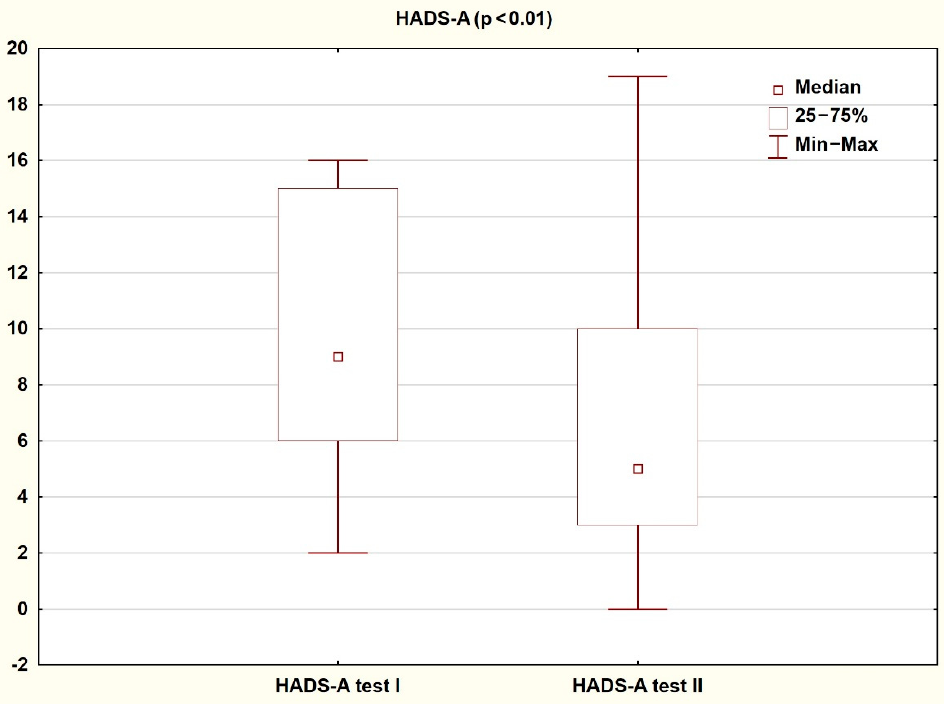
Figure 2. Patient results in the HADS-D subscale during the first and second study (Wilcoxon test).